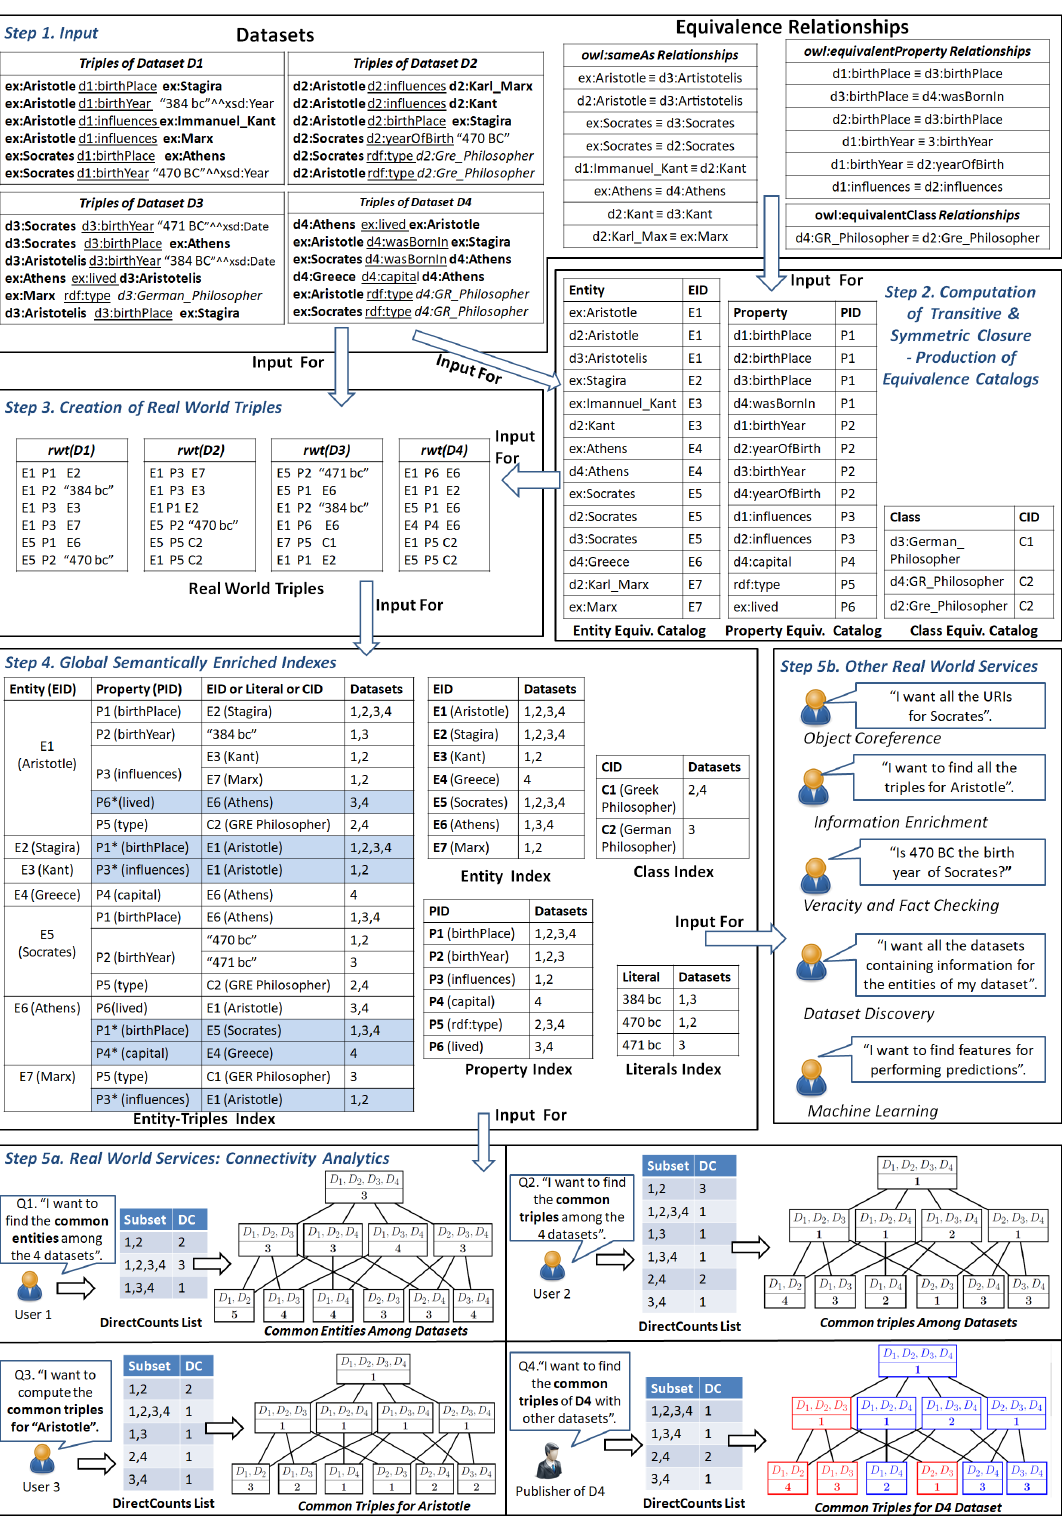
Figure 1. Running example containing four